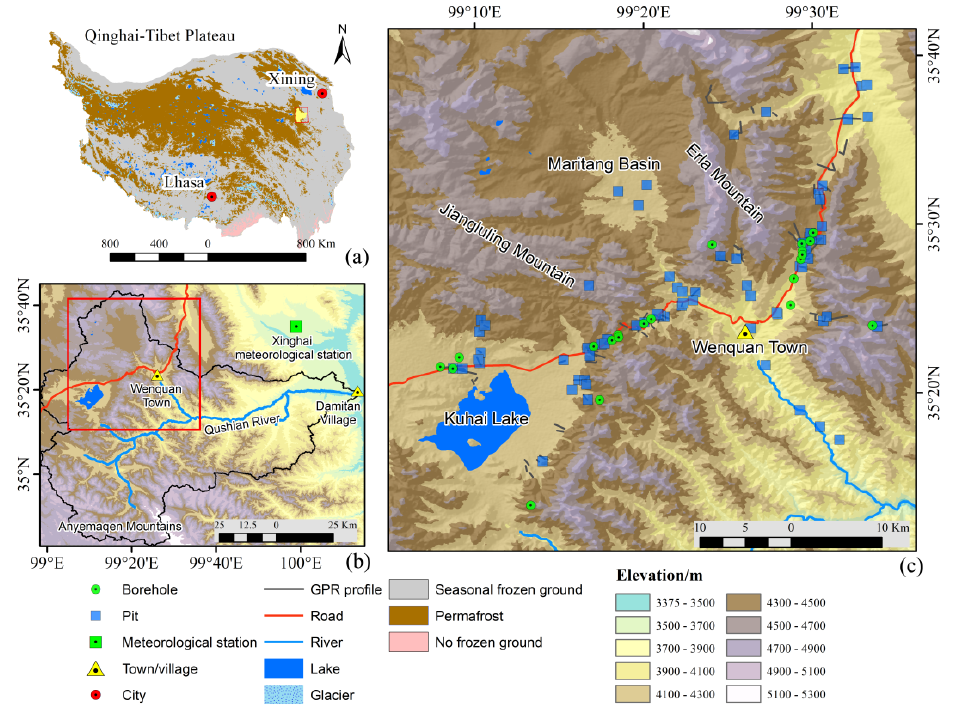
Figure 1. ( a ) Location of the studied region on the Qinghai–Tibet Plateau; ( b ) the scope of the study area; ( c ) the topography of the investigated area with the locations of the field survey sites marked.